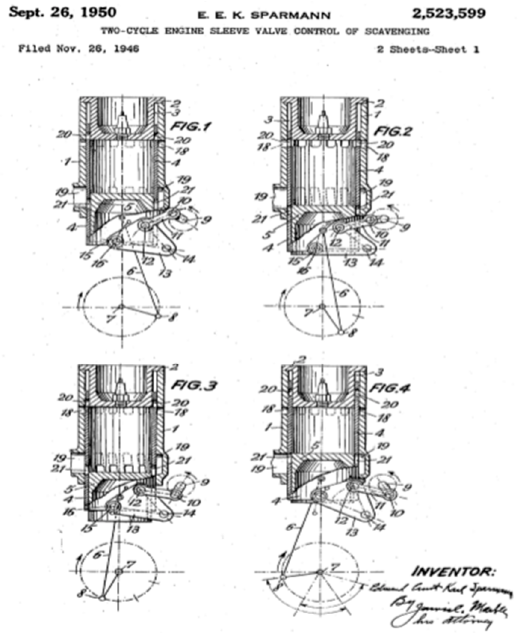
Figure 17. E.E.K. Sparmann 26 November 1946, two-cycle engine sleeve valve control of scavenging